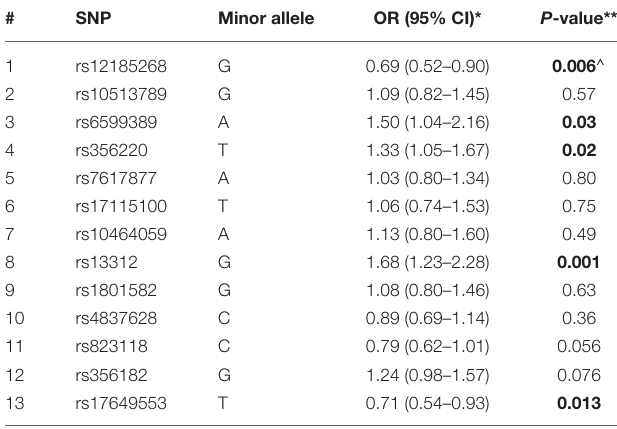
TABLE 4 | OR and 95% CI for the associations between 13 SNPs and PD